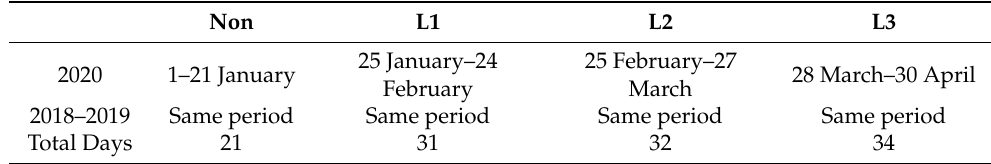
Table 1. Time ranges for response levels of pandemic prevention and control of COVID-19 in Jiangsu Province. Non L1 L2